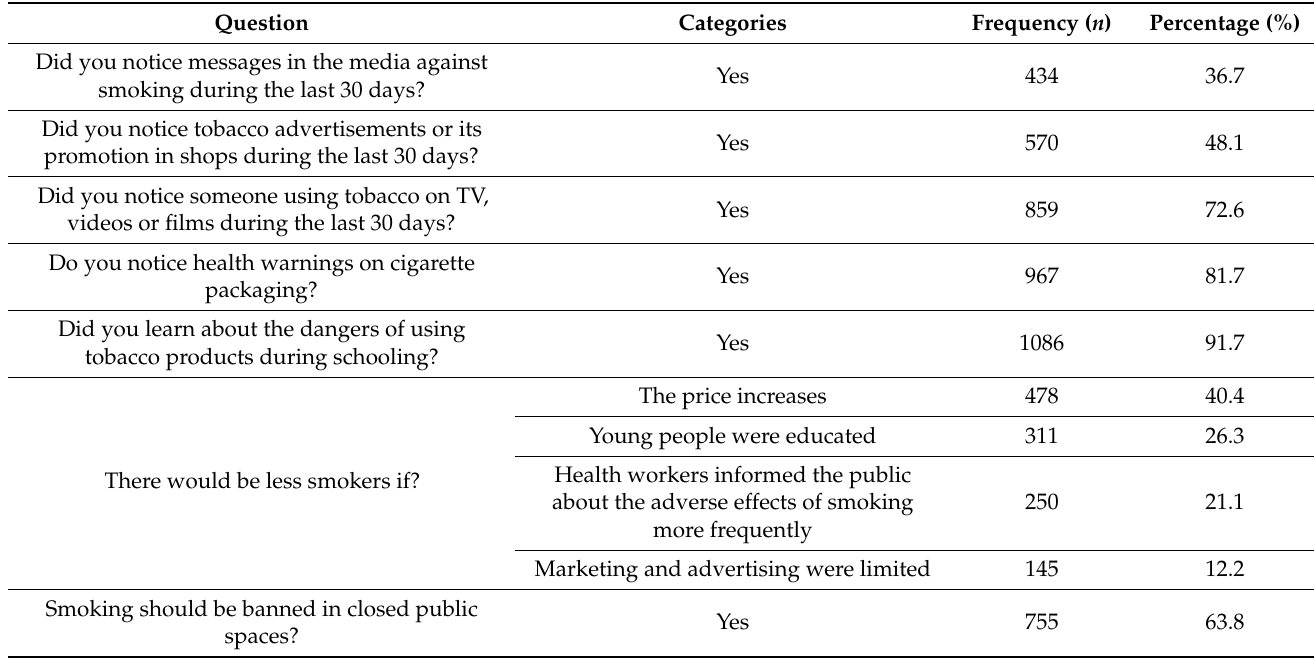
Table 3. Respondents’ opinion on exposure to health warnings and tobacco product advertising messages in relation to the average level of knowledge about tobacco products and their harmful effects ( n = 1184).